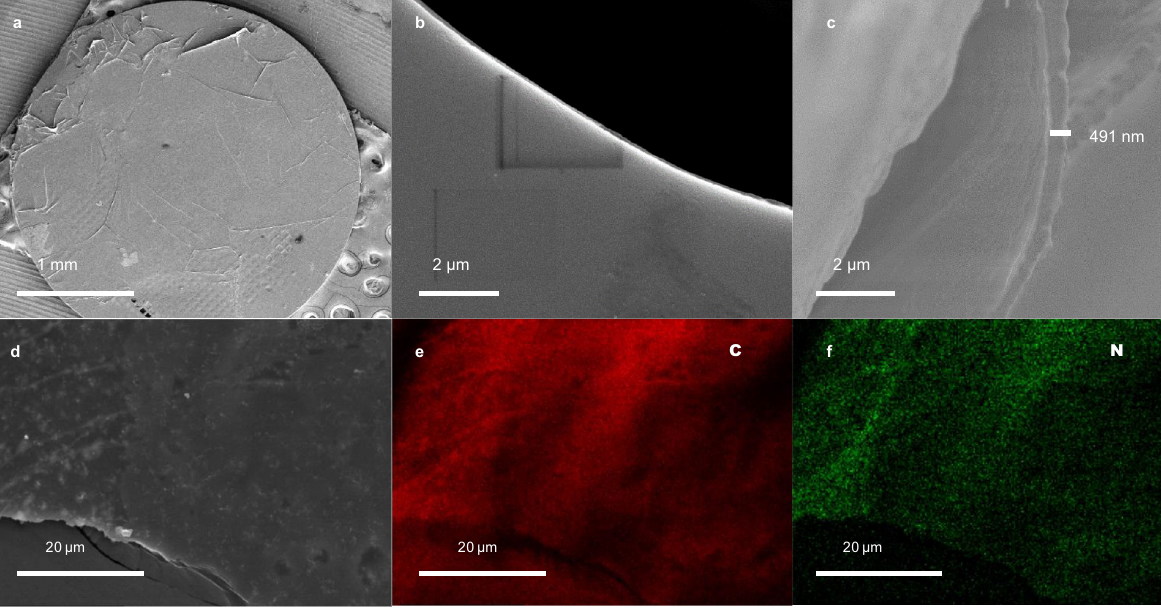
Fig. 5 The morphology analysis of CTF fi lm. a , b SEM images of the fi lm supported on TEM copper grid. c Cross-section SEM image. d SEM image and element mapping: e carbon; f nitrogen. The CTF fi lm was prepared using 6.3 m M